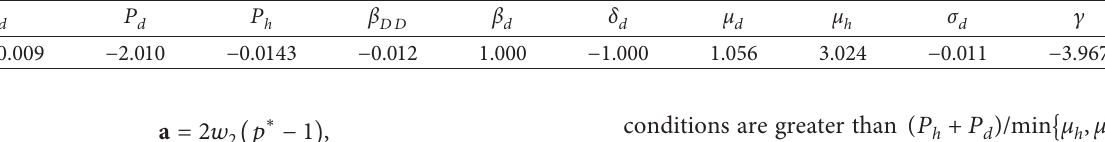
with respect to model parameters. 0